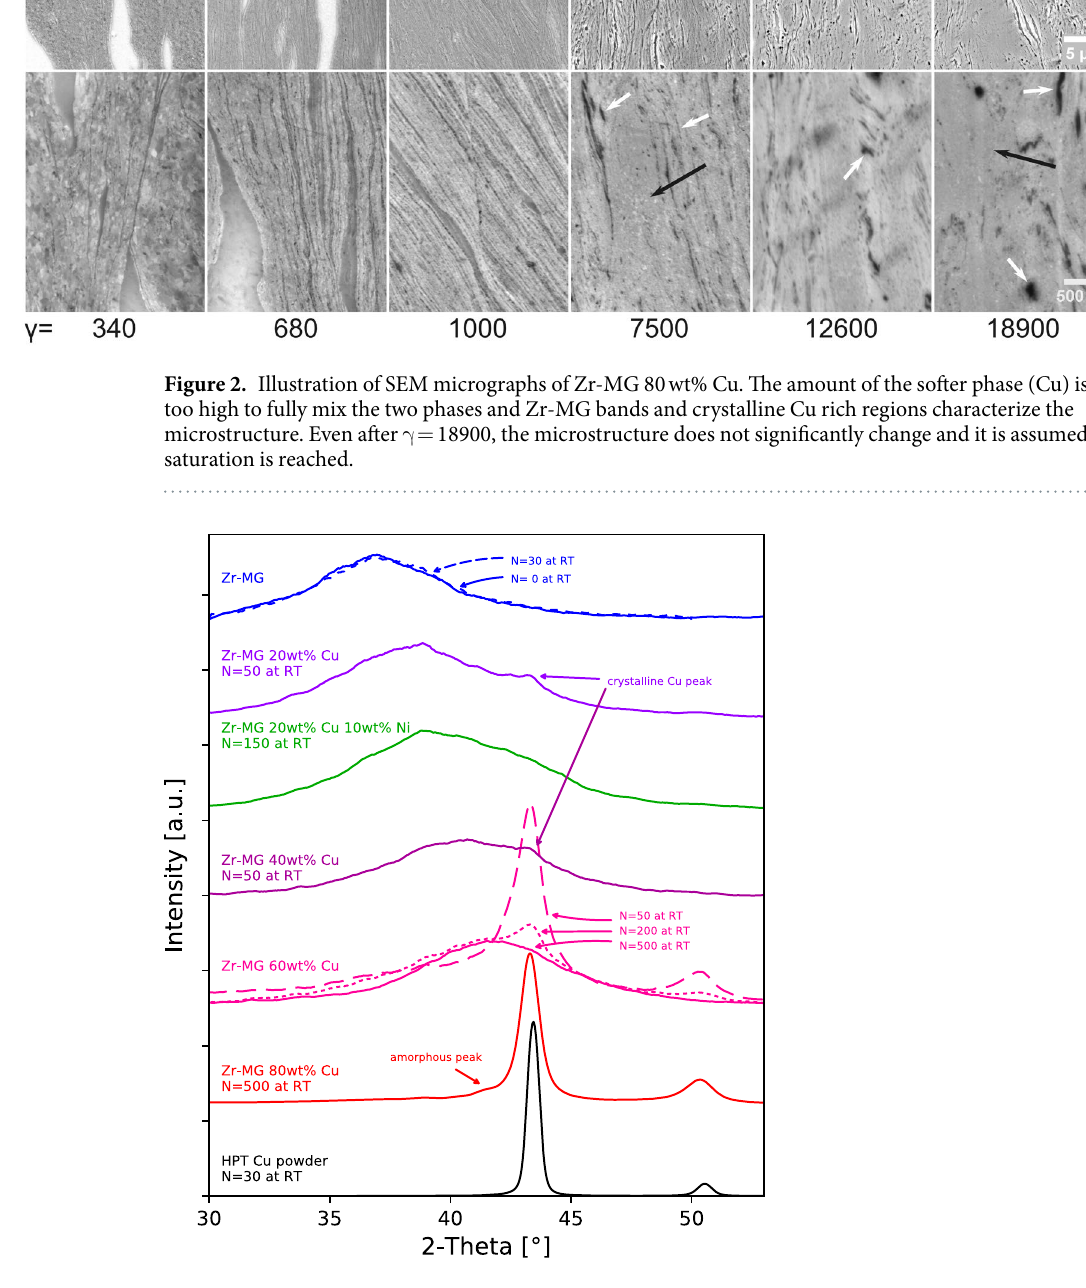
Figure 3. XRD results of different composite concentrations. After sufficient deformation, all compositions except Zr-MG 80 wt% Cu show one broad amorphous peak. For Zr-MG 60 wt% Cu, the evolution of the peaks with different numbers of rotations is indicated: The dominant Cu peak shrinks with increasing strains until only the amorphous peak remains after 500 rotations. The amorphous peak shifts to larger angles with higher Cu